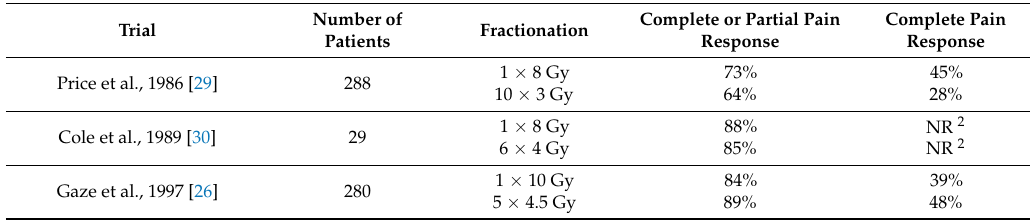
Table 2. Clinical studies demonstrating the analgesic effect of radiation therapy on painful bone metastases depending on dose and fractionation regimen.